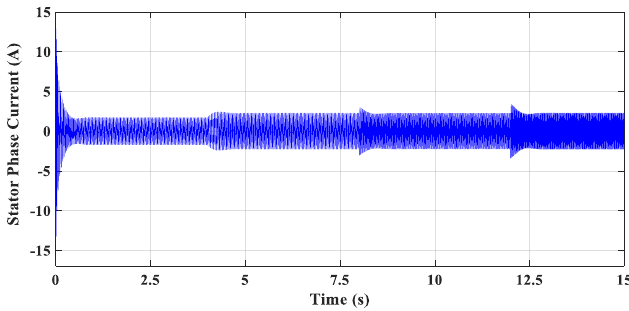
Figure 16. Electromagnetic torque response and the load torque under parameter changes (150% uncertainty).